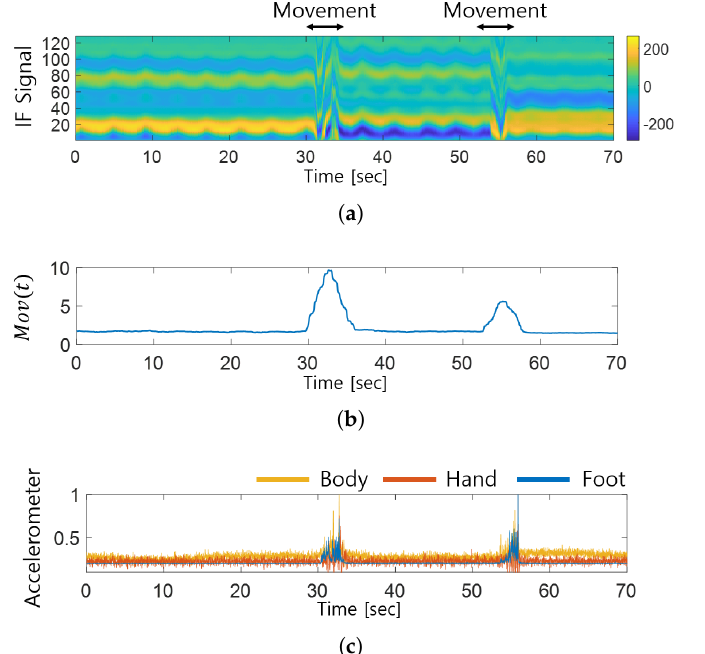
Figure 3. FMCW radar-based movement-detection results. ( a ) Intermediate frequency signal of the radar. ( b ) Motion index Mov ( t ) . ( c ) Accelerometer data for different body parts for